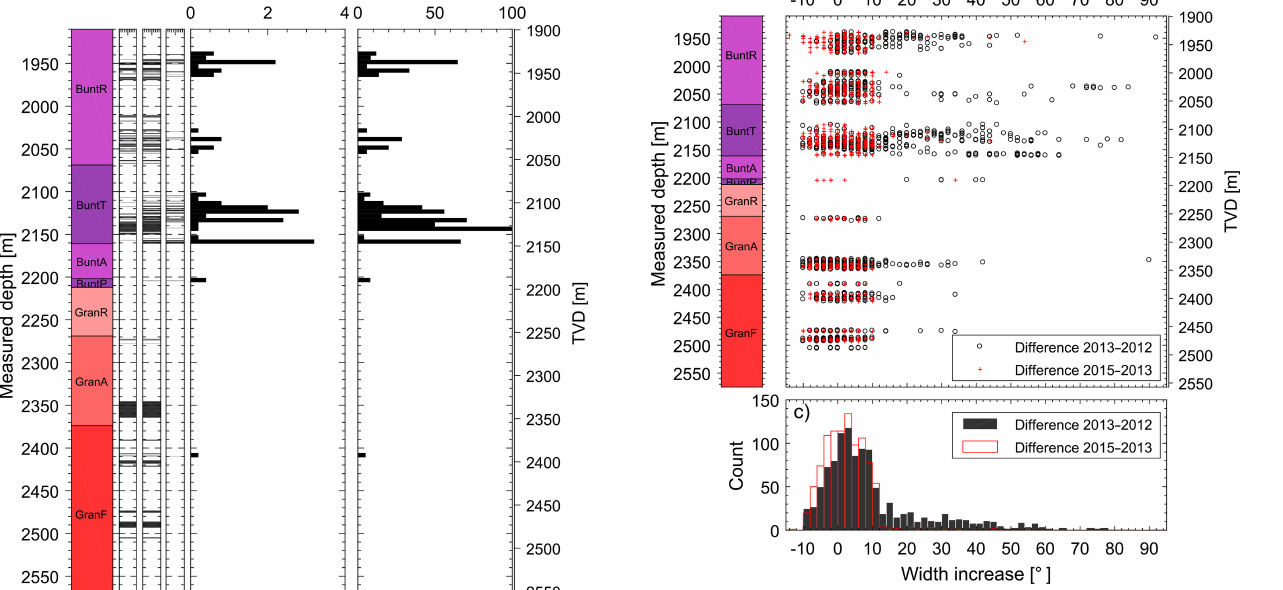
Figure 8. Development of breakouts along the GRT-1 borehole be- tween 2012 and 2013. (a) Simplified lithologies along the GRT-1 borehole as a function of measured depth (MD) or vertical depth (TVD). BuntR stands for Couches de Rehberg, BuntT for Couches de Trifels, BuntA for Annweiler sandstone, BuntP for Permian lay- ers older than Annweiler sandstone, GranR for rubefied granites, GranA for hydrothermally altered granite and GranF for low altered granite. The major fault zone crossing GRT-1 at 2368m is repre- sented as a black band. (b) Breakout positions in GRT-1 in 2012. (c) Breakout positions in GRT-1 in 2013. (d) Intervals at which breakouts are present in 2013 but not in 2012. (e) Breakout length increase (m) along the borehole between 2012 and 2013 in 5m bins. (f) Fraction (%) of wellbore length that was free of a breakout in 2012 but presents a breakout on the 2013 image, computed in 5m bins.